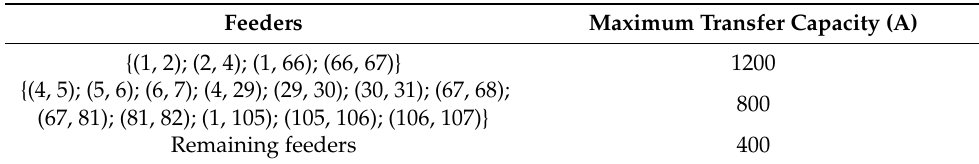
Table 5. The maximum transfer capacity in feeders.